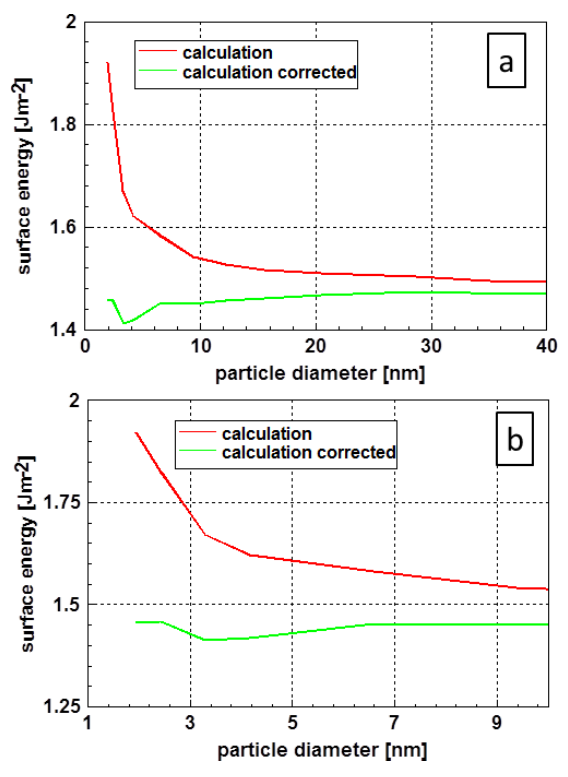
Figure 13: Results of molecular dynamic calculations of the surface energy of gold [54]. (a) All the results, whereas the range of small par- ticles is displayed in more detail in (b). It is important to realize the increase of the surface energy that occurs after the minimum around the 3 nm particle diameter mark. The values corrected according to Holec et al. [53] take the physical size of the nanoparticles into